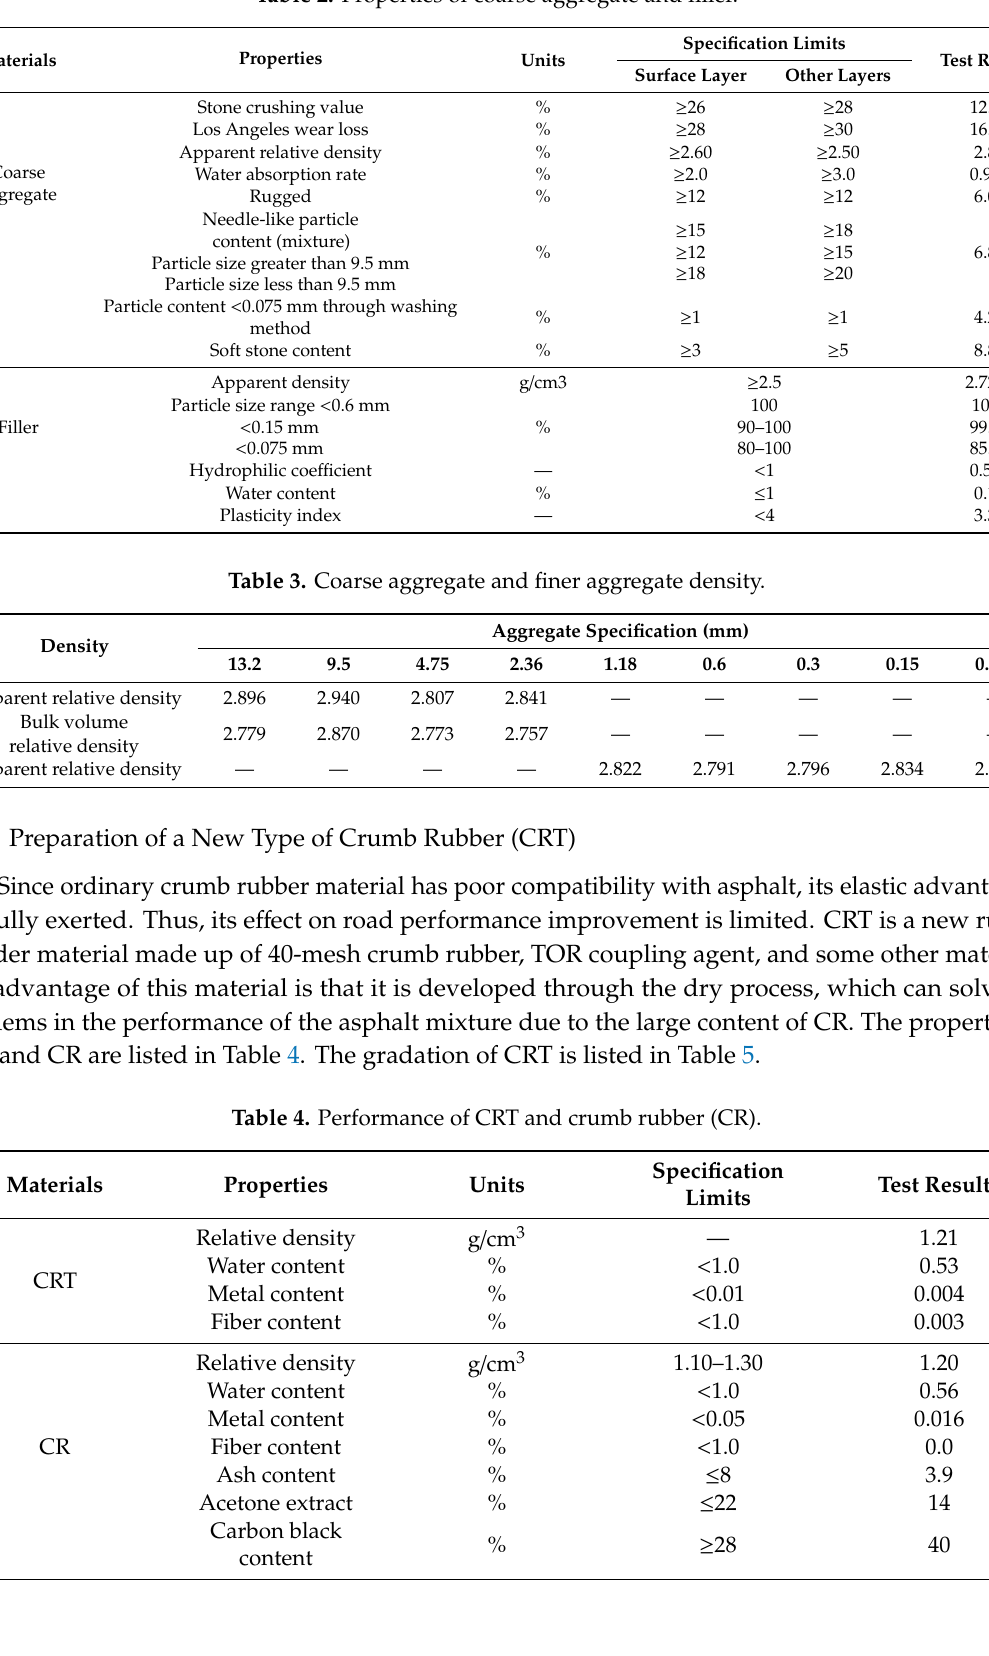
Table 2. Properties of coarse aggregate and filler.